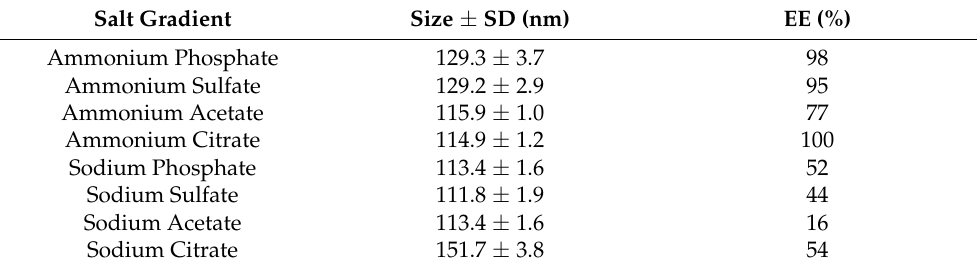
Table 1. Summary of the size and encapsulation efficiency of loaded liposomes achieved via differ- ent